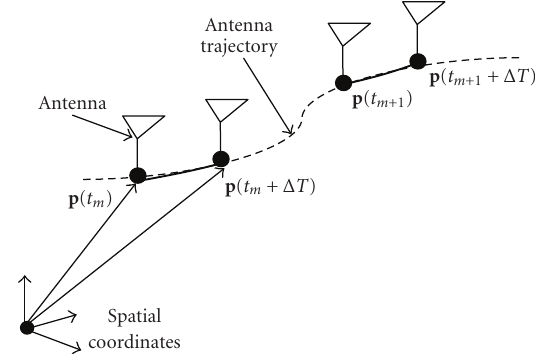
Figure 1: Synthetic array model illustrating signal collection over the m th and ( m + 1)th